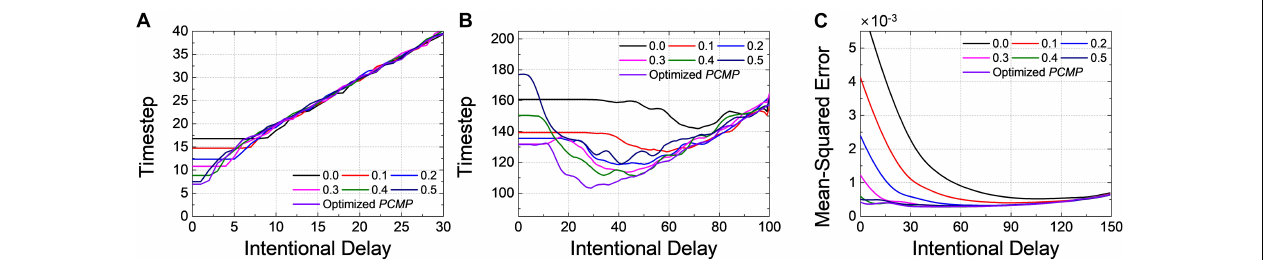
FIGURE 11 | Changes of timestep when 99.0% of the ANN’s accuracy is reached with respect to the intentional delay for (A) Net 1 and (B) Net 2 . Changes of MSE at 1-epoch (255th timestep) for (C) Net 3 . Different levels of the global and the optimized PCMP are used for Net 1 ∼ 3 . Delayed evaluation ( DE ) is effective to achieve the further reduction of the latency, and it can be applicable simultaneously with PCMP .